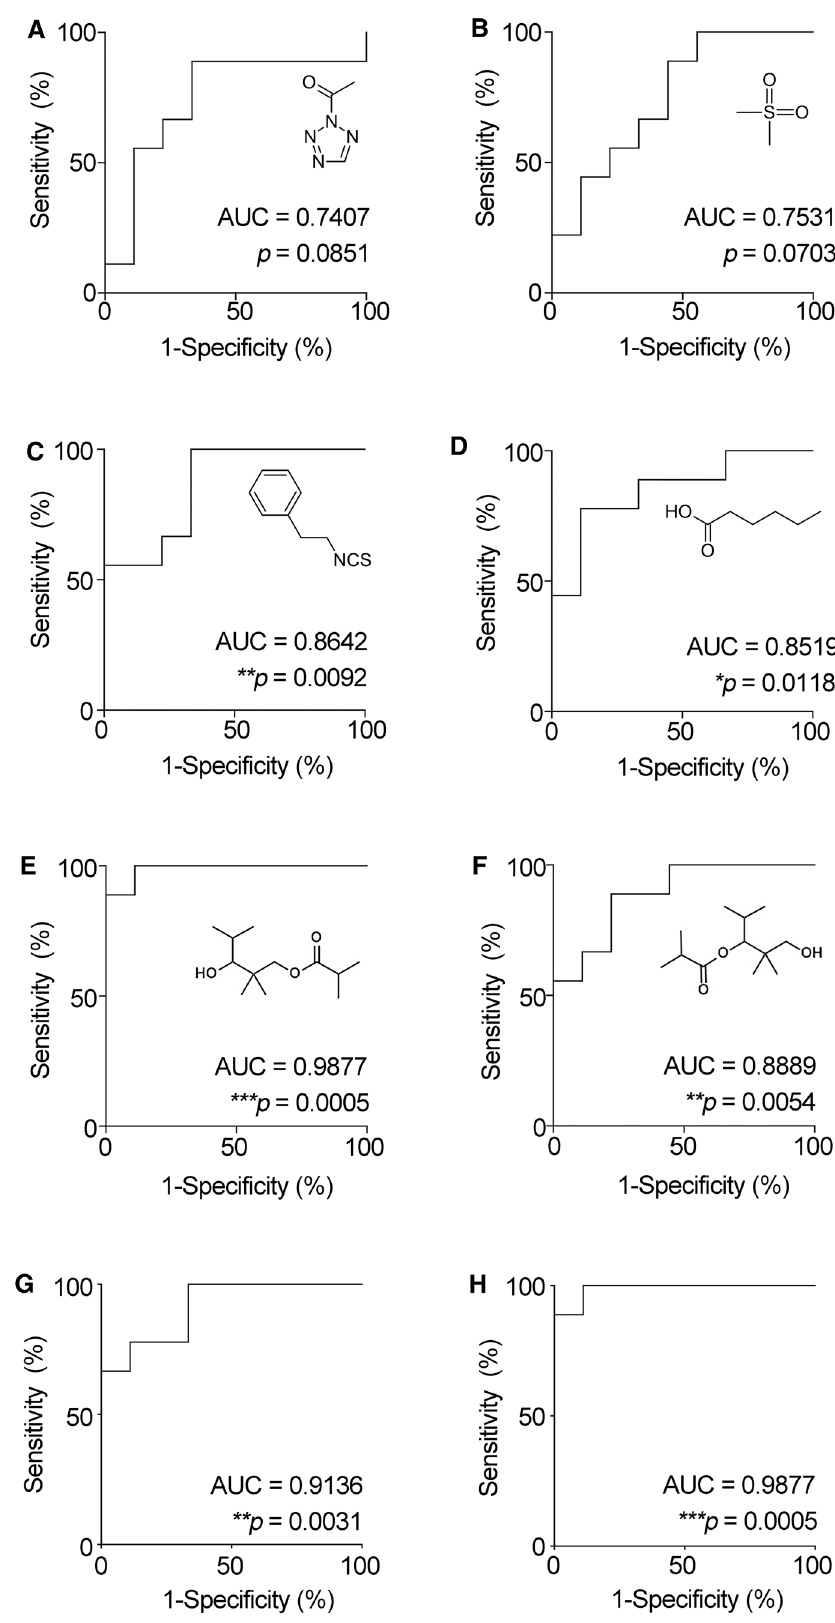
Fig. 3 Receiver operating characteristic curves show- ing the differential amounts of urine volatile organic compounds between the two diagnostic groups.